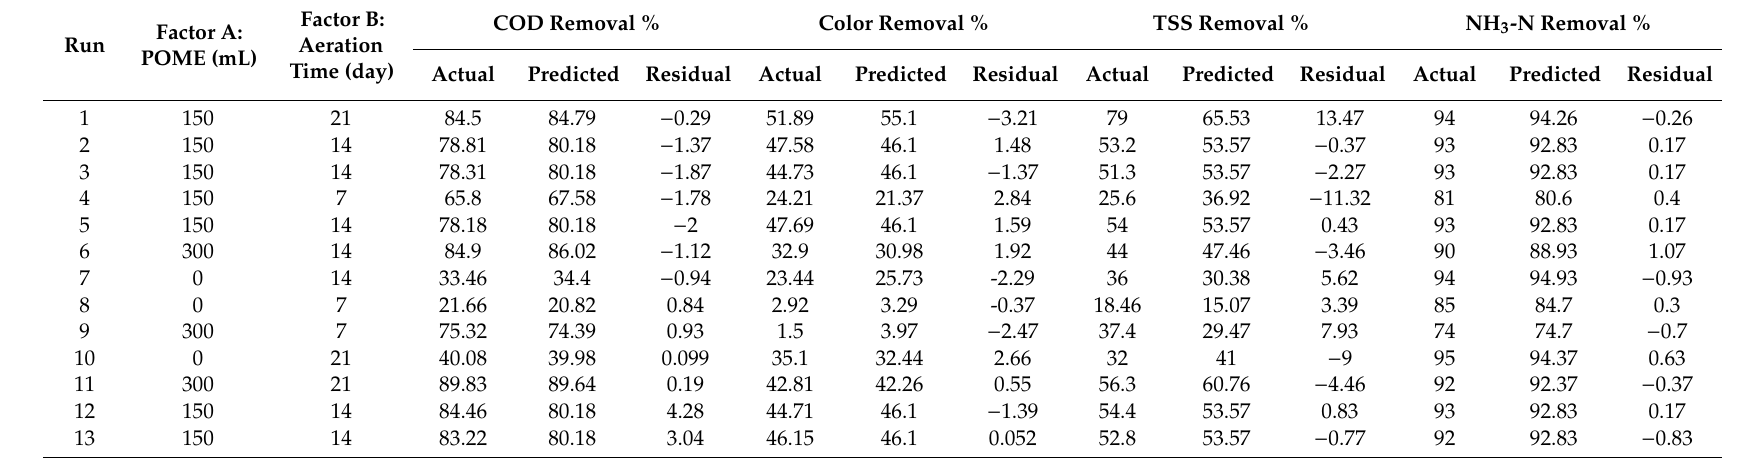
Table 3. Response value for di ff erent experimental conditions (POME dosages and aeration